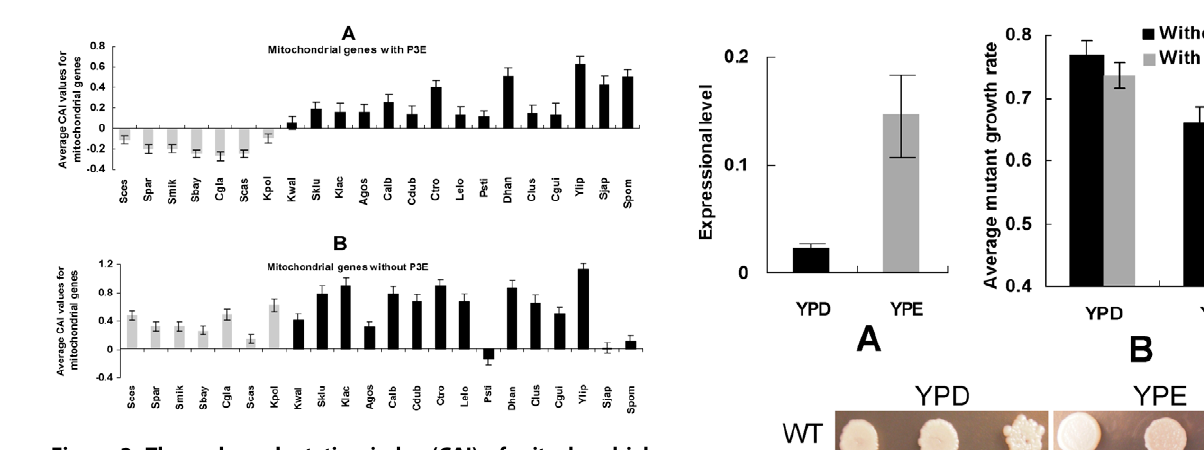
Figure 3. The codon adaptation index (CAI) of mitochondrial genes in species in the clade Saccharomycotina . The grey and black bars denote the post and pre-WGD fungi species, respectively. The average CAI values of the mitochondrial genes with P3E (A) and without P3E (B) were shown. The student t-test was used to compare CAI values between pre- and post-WGD fungi species.